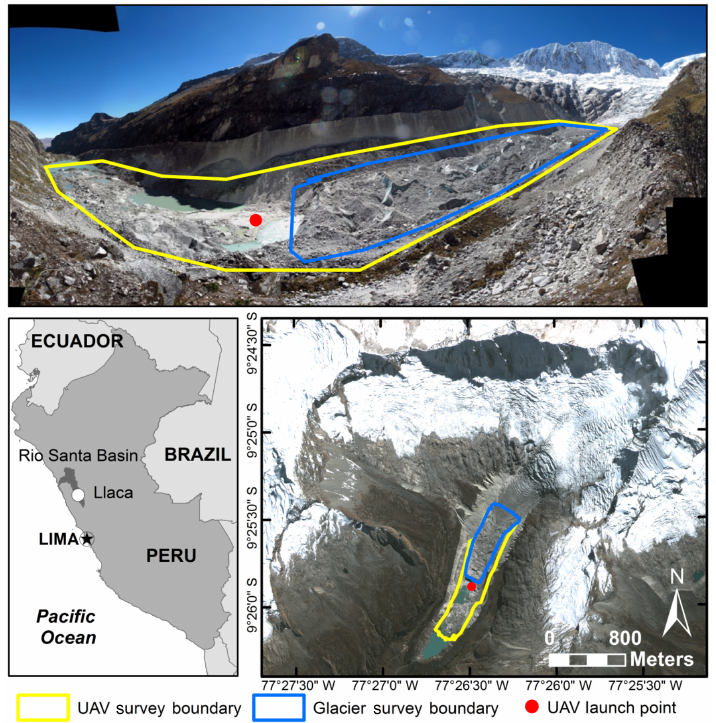
Figure 1. Llaca Glacier location map within the Cordillera Blanca. Showing UAV launch point and survey area boundaries. UAV survey boundary (yellow line) is maximum extent of study area covered by both 2014 and 2015 surveys. The glacier survey boundary (blue line) is the maximum extent of the glacier tongue covered by both 2014 and 2015 surveys.